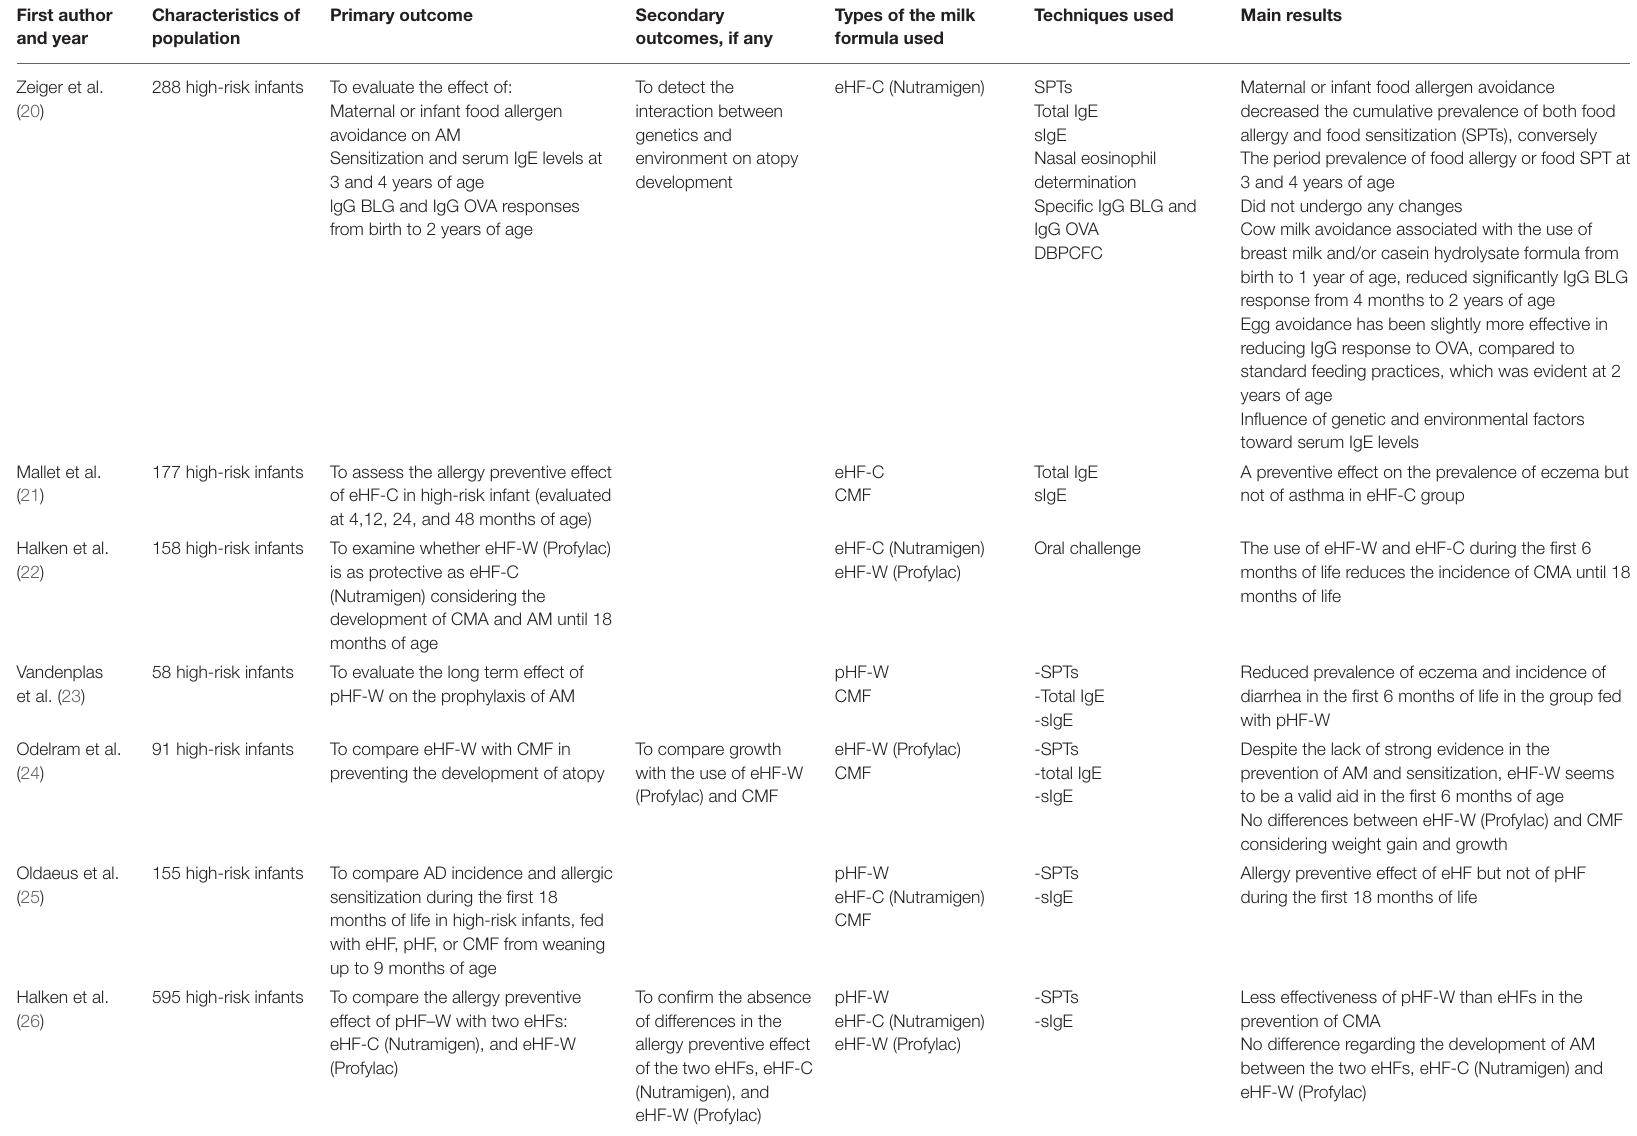
TABLE 3 | Summary of RCTs assessing the role of different HF on allergic